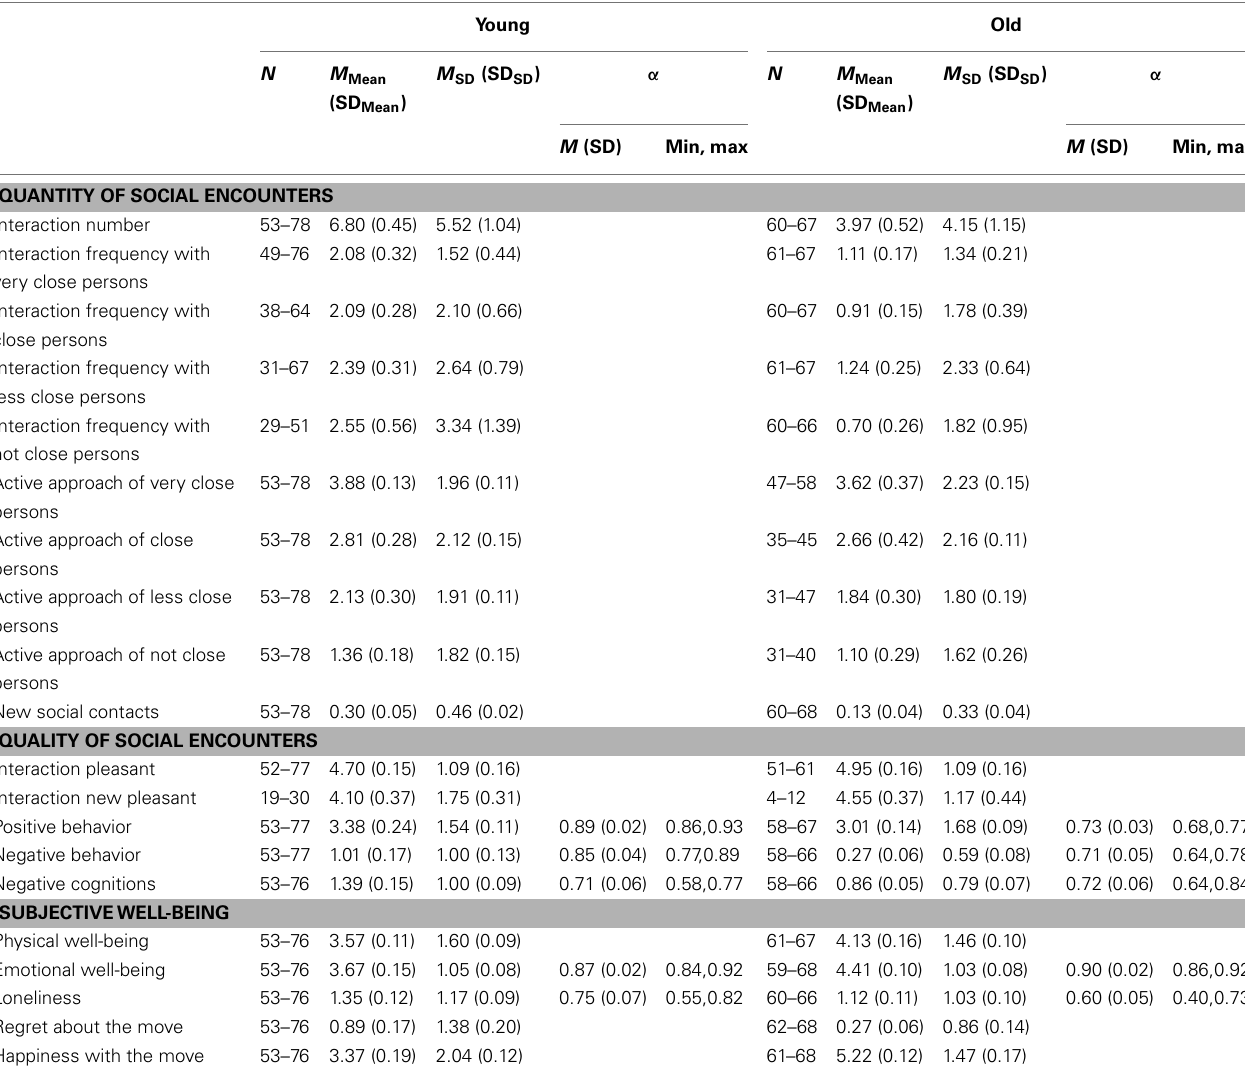
Table 1 | Descriptive statistics of the diary